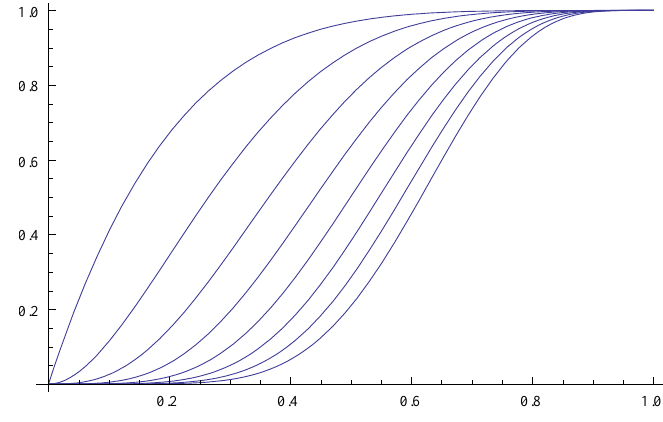
Figure 3. The reliability polynomial of the linear < n ,5,2> for n =